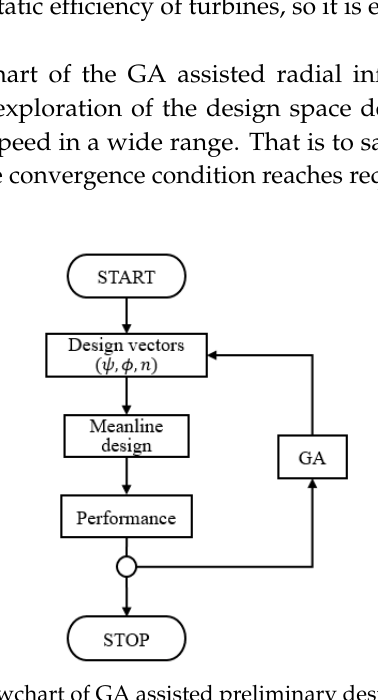
Figure 4. Genetic algorithm (GA) procedure.